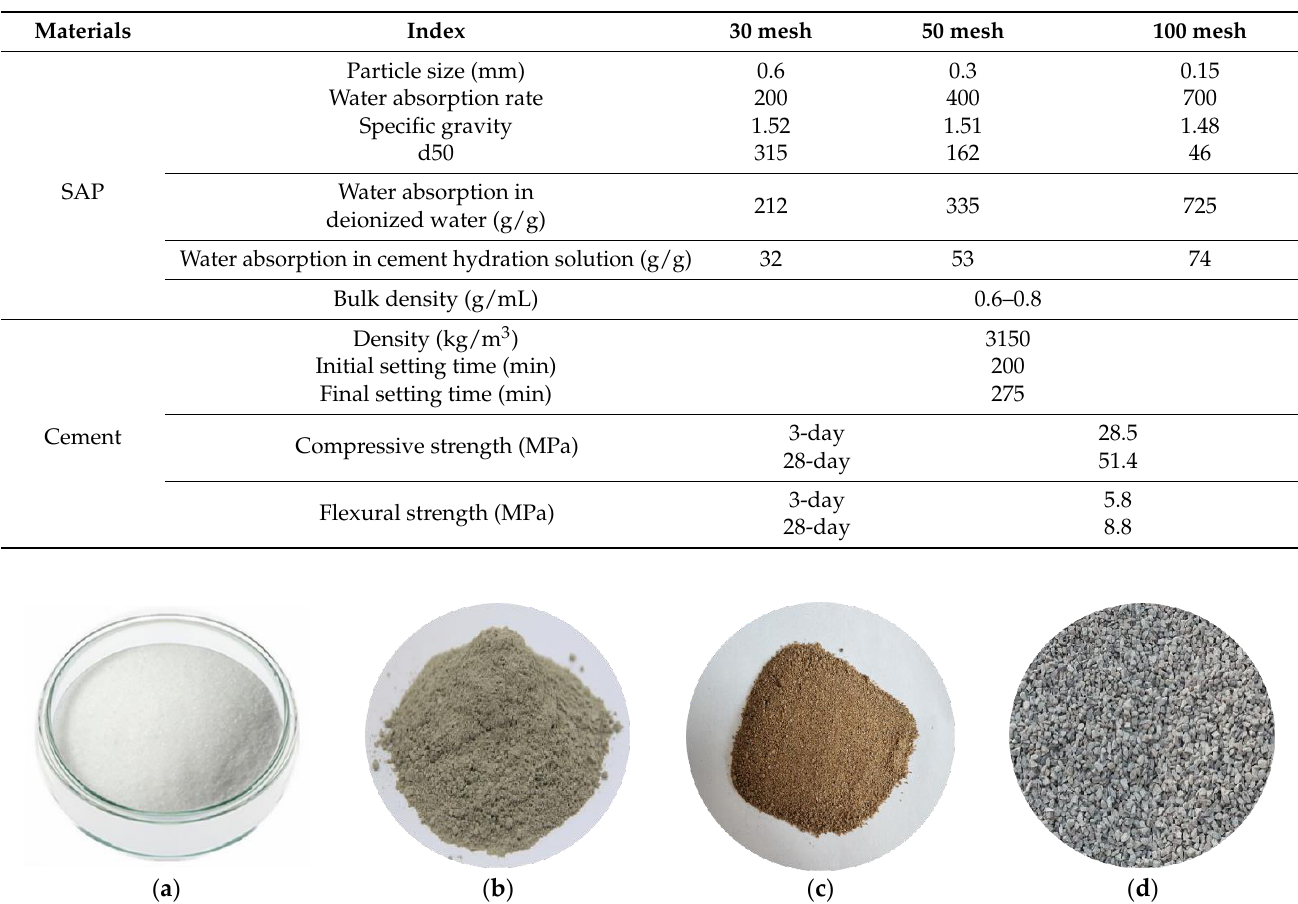
Table 1. Basic performance indicators of SAP and cement. Adapted from ref. [3].